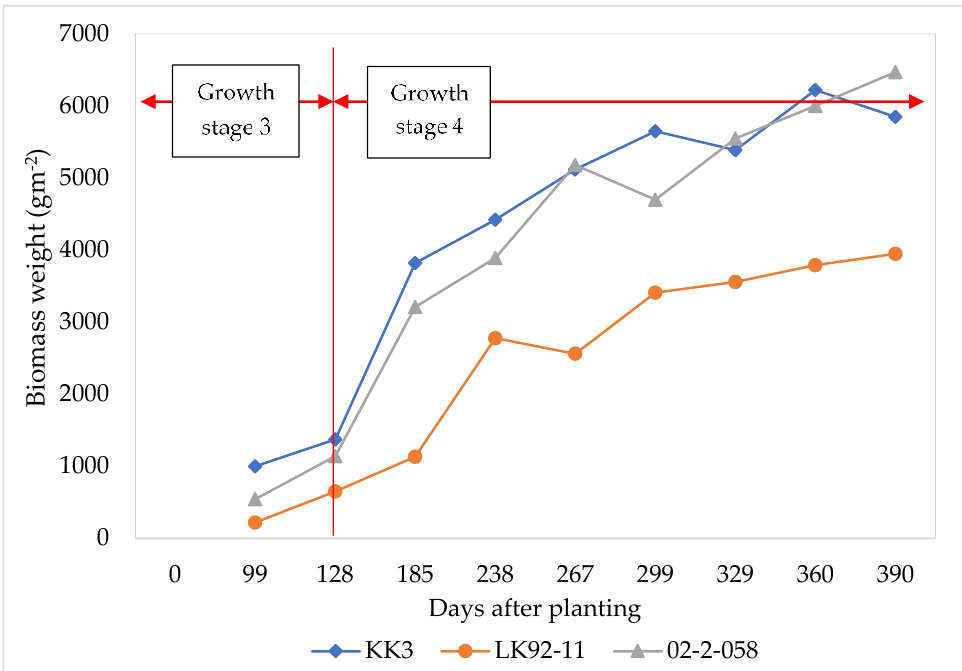
Figure 10. Observed biomass weight (gm −2 ) of selected parameter ensembles of each cultivar under optimized experimental conditions. Cultivars KK3 and 02-2-058: observed biomass yield in experiment B1 and cultivar LK92-11: observed biomass yield in experiment B2. Growth stages were obtained from the APSIM-Sugarcane simulations using the corresponding parameter ensemble and APSIM simulation files.